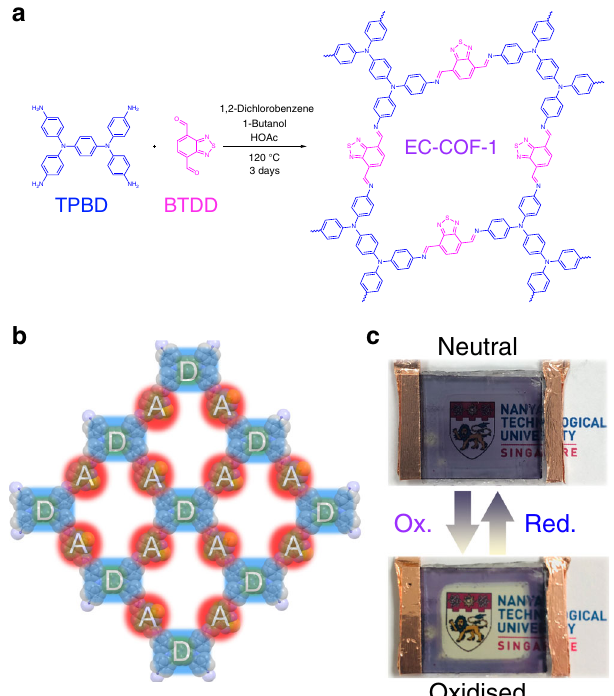
Fig. 1 Synthesis and device of EC-COF-1. a Synthetic route of EC-COF-1. b Schematic representation of a layer structure of donor (D) – acceptor (A) EC-COF-1. c Colour switching of the EC-COF-1 EC